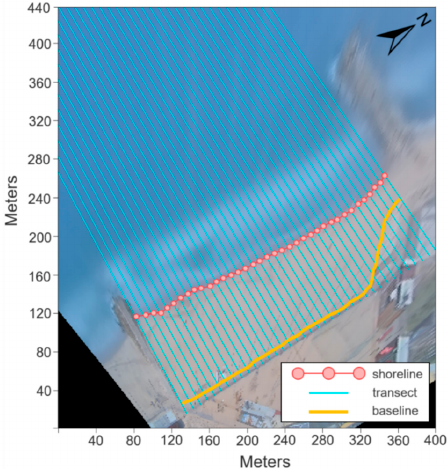
Figure 3. Manual shoreline detection procedure performed in Matlab environment. The red circles indicate the point where each transect intercepts the limit between water and dry sand, and the whole set of 37 points represent the shoreline position. The yellow line indicates the baseline, which corresponds to the position of the beach wall, against which the shoreline position is measured. The baseline chosen corresponded to the beach wall backing the beach. Therefore, the actual cross-shore extent of the emerged beach was found by subtracting the baseline, at each transect, from the shoreline position. The shoreline variation analysis consisted in comparing the shorelines detected over the monitored period.